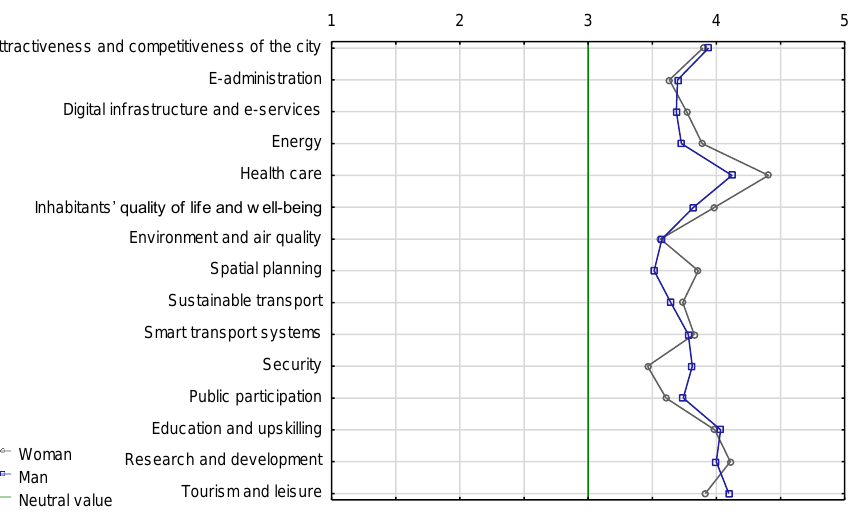
Figure 14. Semantic differential for the necessity of introducing changes in individual aspects of the functioning of the city of Suwałki, by gender. Source: own study based on questionnaire surveys.